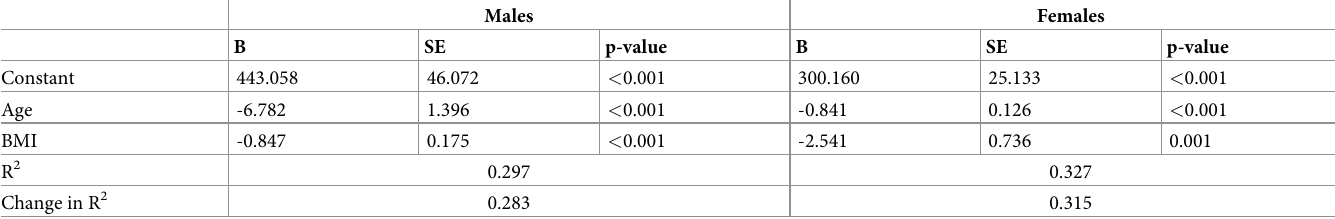
Table 4. Results of stepwise multiple linear regression analysis of the independent variables that explained the 2MWD (m).